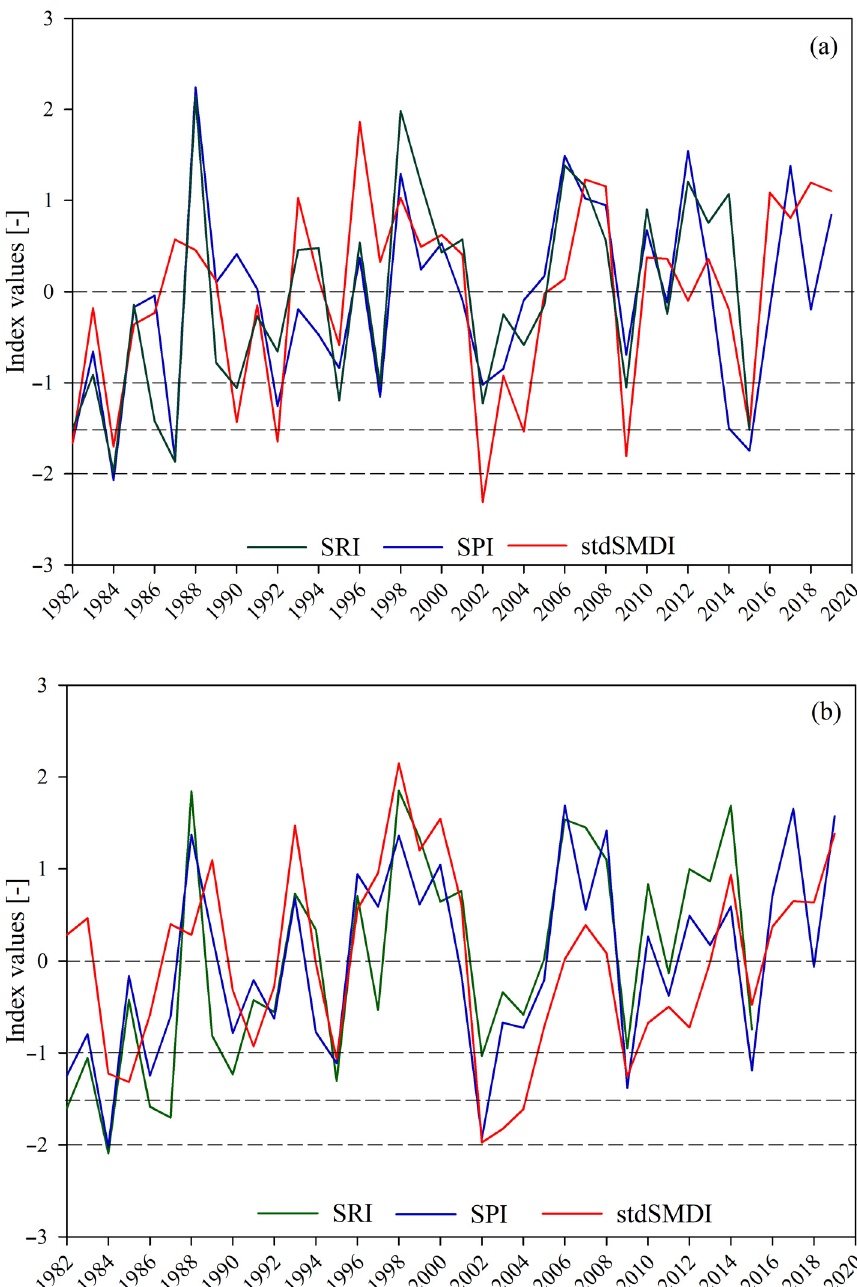
Figure 6. The temporal patterns of meteorological (SPI), agricultural (stdSMDI), and hydrological (SRI) droughts for Kiremt ( a ) and annual ( b ) aggregate periods from 1982–2019. The time span for hydrological drought is from 1982–2017 due to the inaccessibility of the recent flow data. The broken lines show the different drought severity categories as explained in Table 1.